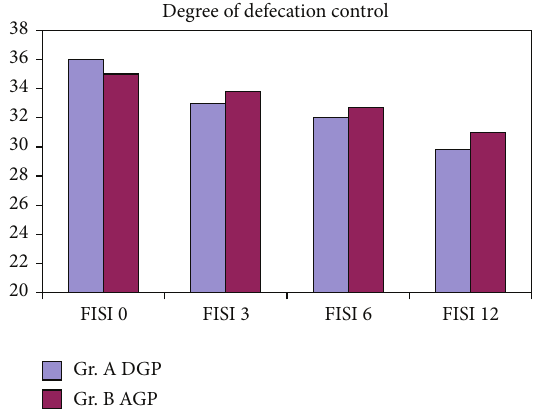
Figure 2: Fecal incontinence